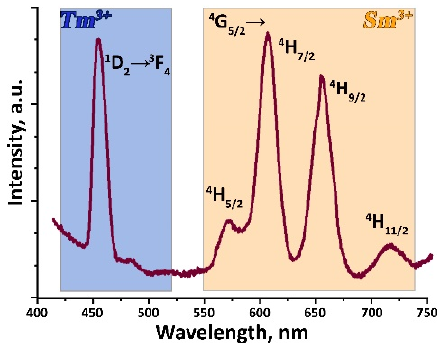
Figure 7. PL spectrum of Ca 9 Gd 0.8 Tm 0.1 Sm 0.1 (PO 4 ) 7 , λ ex = 356 nm.